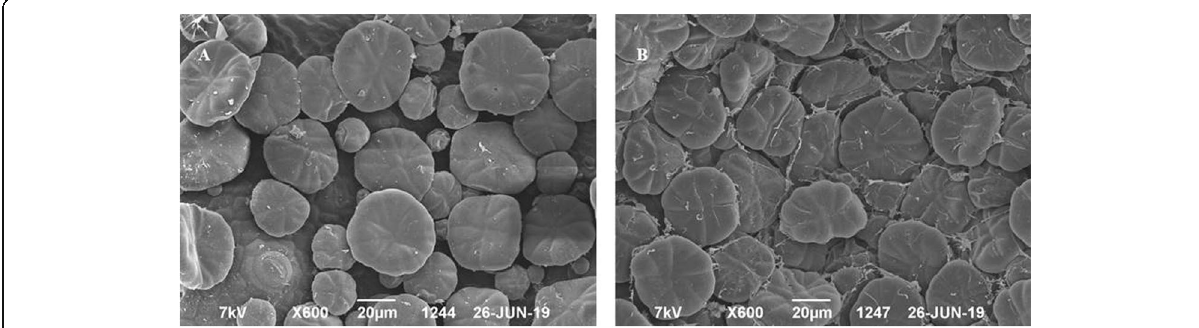
Fig. 1 Scanning electron micrograph of the M. hortensis leaf surface after critical-point drying ( a ) without OsO 4 and ( b ) with OsO 4 . Imaged at 7.00 kV with a magnification of X600. Scale bar represents 20 μ